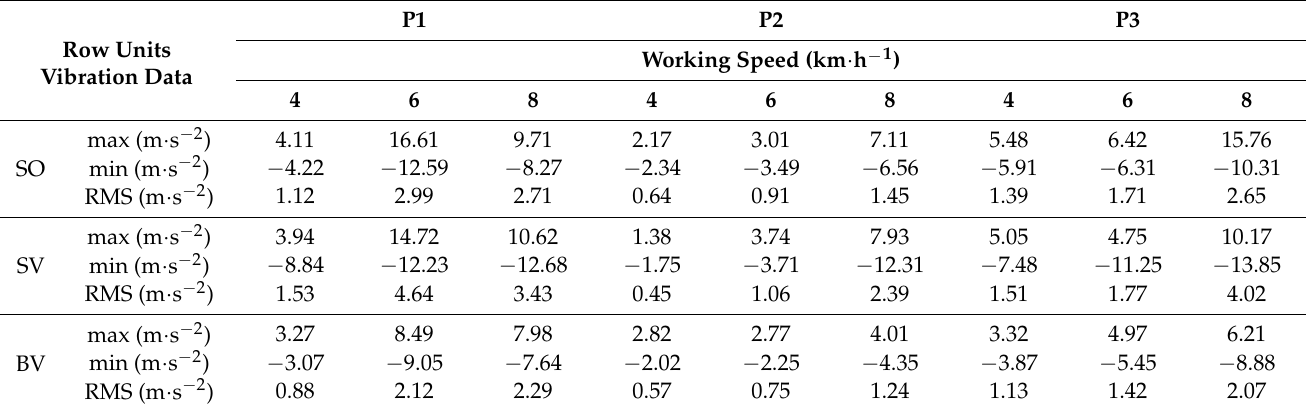
Table 4. Statistic values of